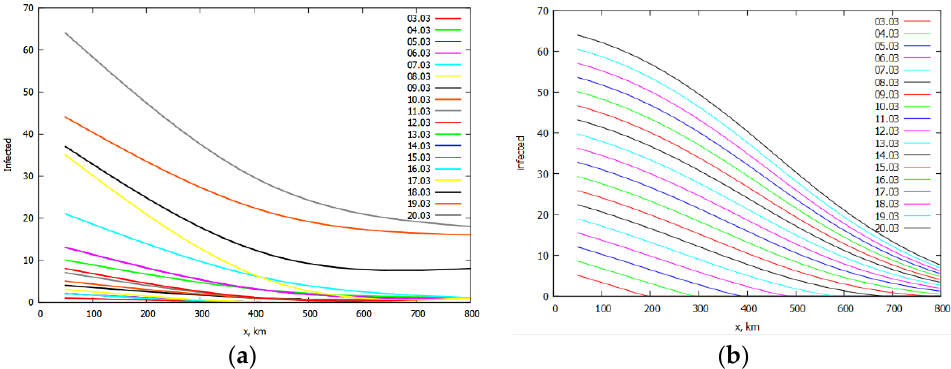
Figure 7. Graphs of 𝑛 𝑀 (𝑡, 𝑥) for southern Chile. ( a ) Real data. ( b ) Theoretical results.